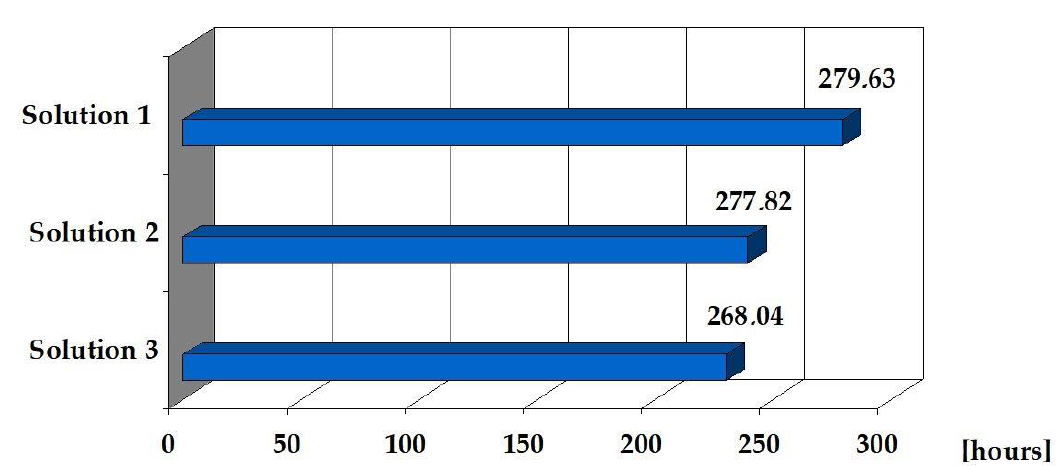
Figure 5. Time of processing walls, ceilings, and stairs in the building to be implemented according to three solutions.